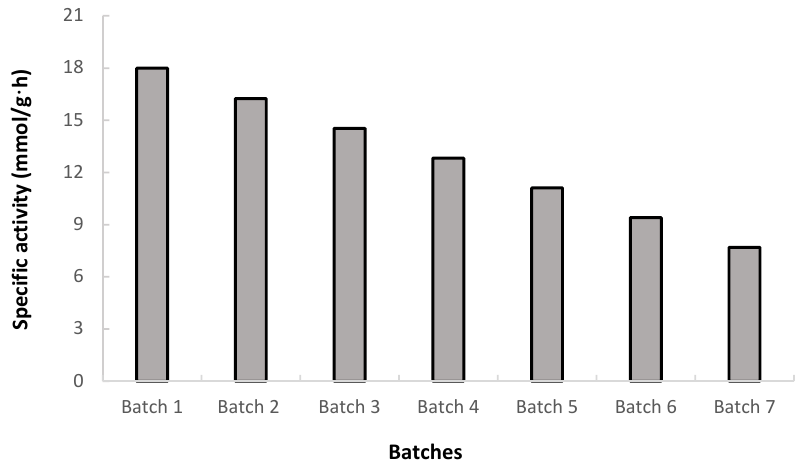
Figure 8. Specific activity during the operation of sequential enzymatic reactors with monophasic first-order inactivation kinetics, k d = 0.02 h − 1 and reactivation k r = 0.1 h − 1 .